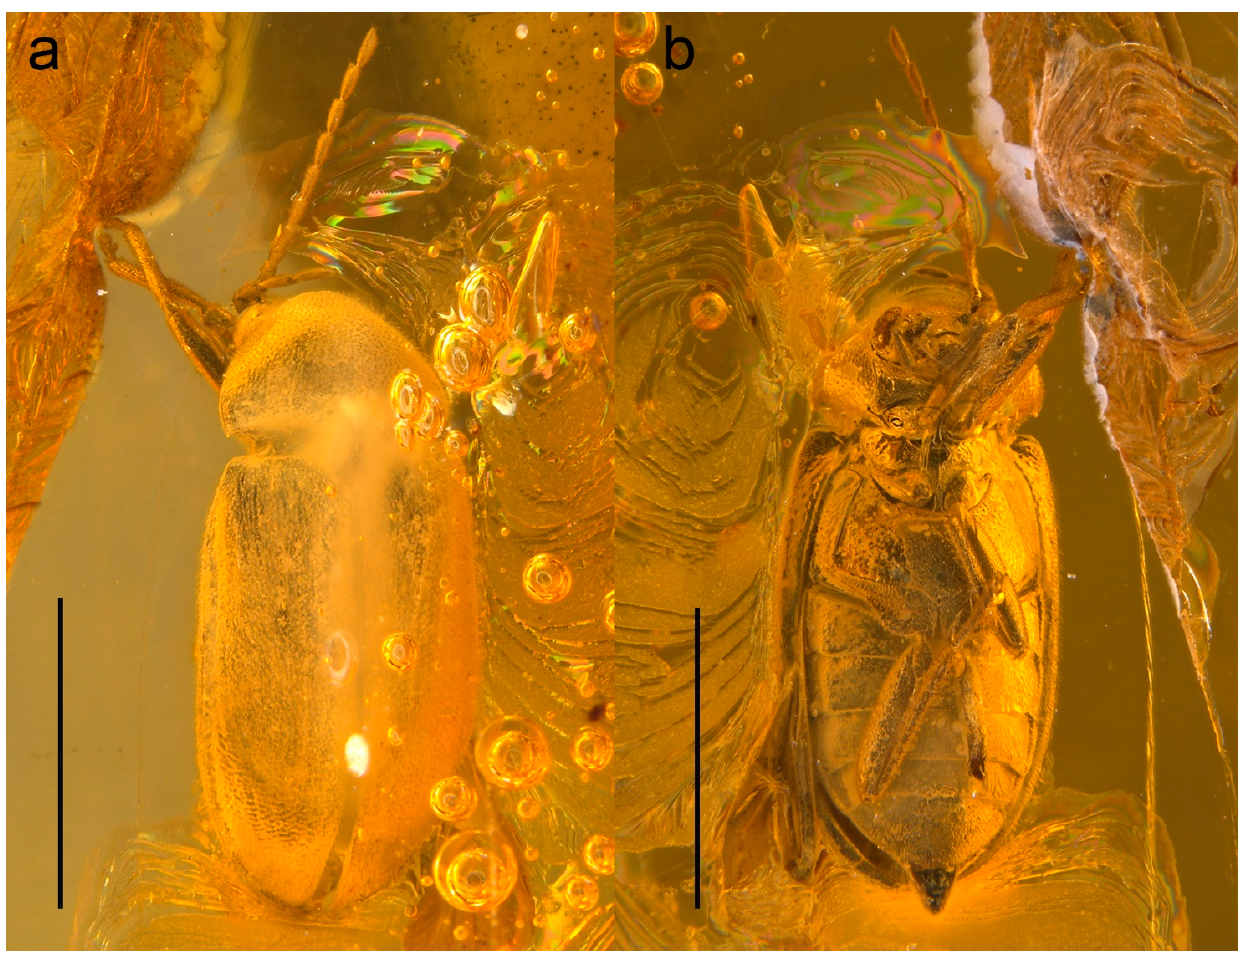
Figure 1. Ptilodactyla eocenica Kundrata, Bukejs and Blank, sp. nov., habitus. ( a ) Dorsal view; ( b ) ventral view. Scale bar = 3.0 mm.